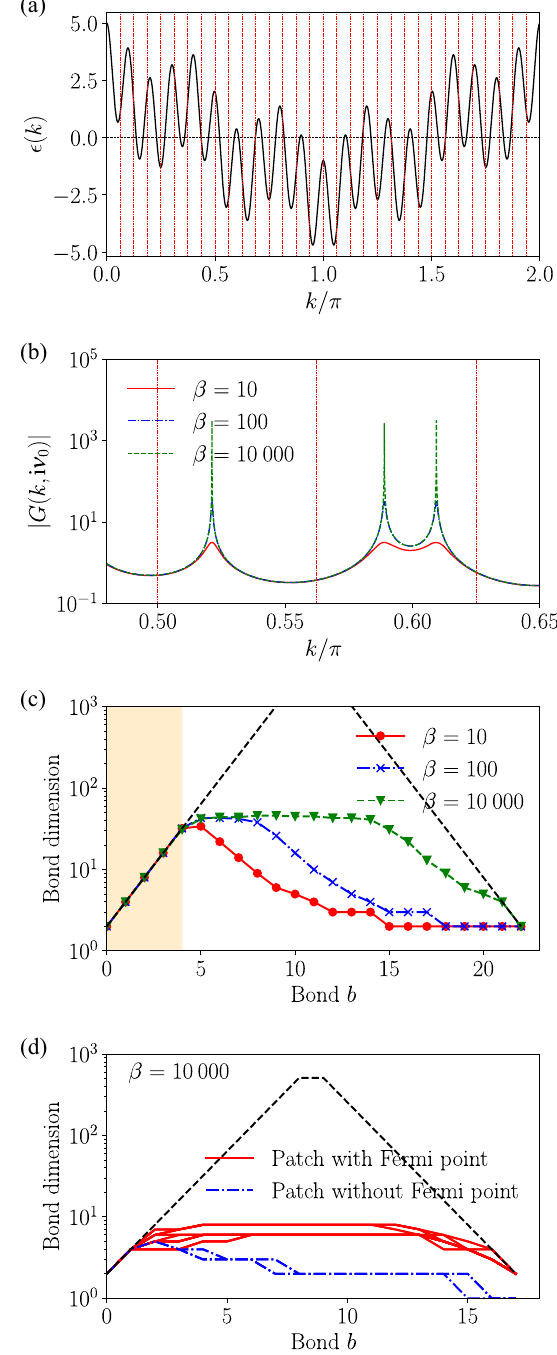
FIG. 9. Momentum dependence of the Matsubara Green ’ s function of the 1D tight-binding model (16). (a) Band dispersion, (b) Green ’ s function at the lowest positive Matsubara frequency, (c) bond dimensions of a MPS for the full BZ, and (d) bond dimensions of patchwise constructed MPSs. We use ϵ ¼ 10 − 10 and 2 5 ( ¼ 32 ) patches in (d). The vertical lines in (a) denote the boundaries of the patches. ϵ ð k Þ has 34 roots. The shaded region in (c) corresponds to the patch size. Two out of the 32 patches do not contain a Fermi point. In (d), the dashed line indicates the maximum bond dimensions in maximally entangled cases.